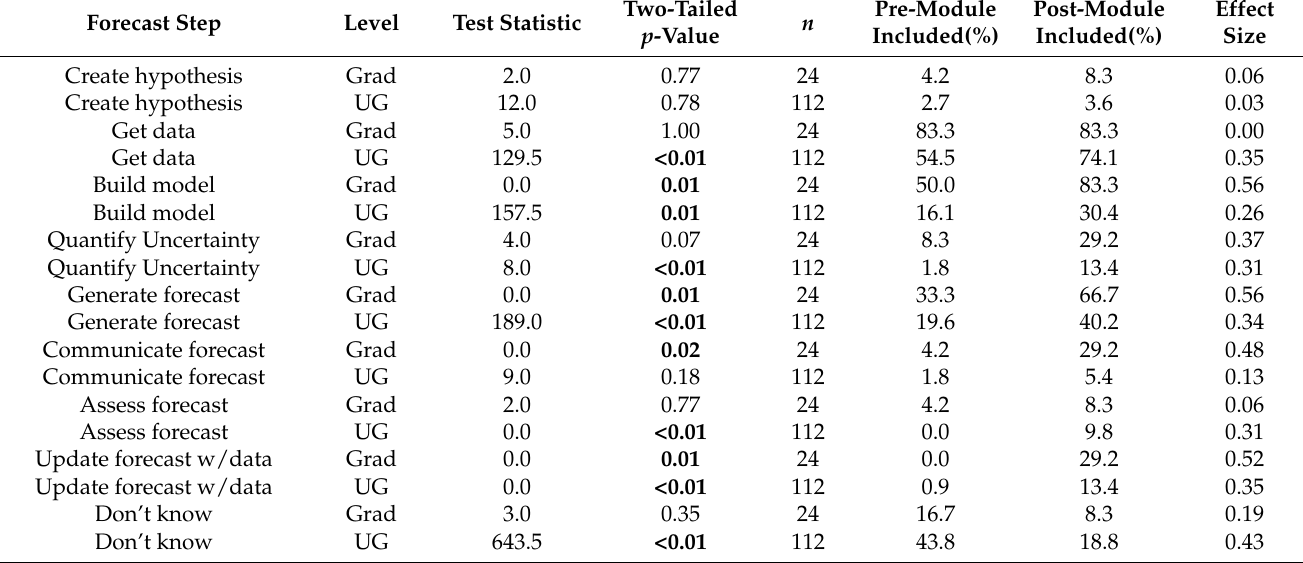
Table A8. Differences in the percentage of students’ which included each of the forecasting steps in their response to Q 5 (Table S3) between pre- and post-module assessments for graduate (Grad) and undergraduate (UG) level of students. Test statistics and p -values are for paired, two-sided Wilcoxon signed-rank tests; pre- and post-module percentages are included. Significant p -values ( p < 0.05) are shown in